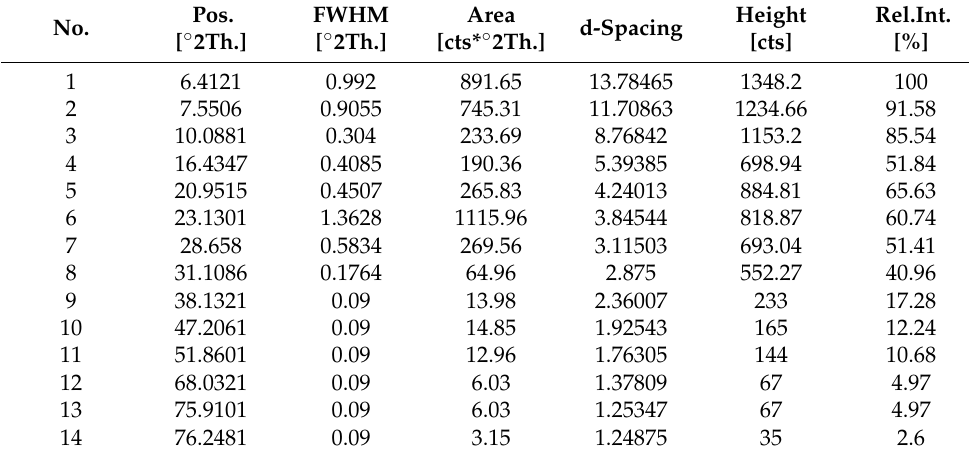
Table 2. X-ray diffraction peaks of GMA